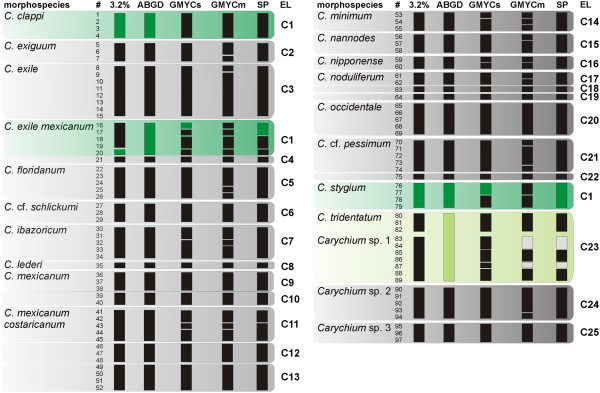
Molecular delimitation of Carychium evolutionary lineages. Results of the five genetic delimitation approaches are indicated. For Carychium, 97 specimens (#) comprising 18 morphospecies and three undescribed taxa are analysed. A conservative strategy identified 25 evolutionary lineages (EL; C1-C25). Specimens clusters identified under each single delimitation method (3.2%, ABGD, GMYCs, GMYCm and SP) are indicated by black boxes. Grey boxes refer to clustered specimens within a single morphospecies (e.g. SP, # ‘83’ + ‘84’ + ‘87’), colored boxes to specimens between different morphospecies (e.g. SP, # ‘16’ + ‘17’ + ‘76-79’).